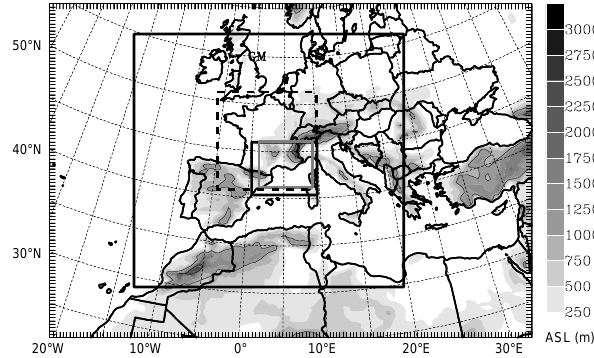
Fig. 1. Domains of the HRA2.5 (in solid grey) and RAI (in solid black) simulations. The boundaries of the AROME model are drawn with dashed black lines. The orography is displayed in grey scale with a solid contour at the 1000m and 2000m